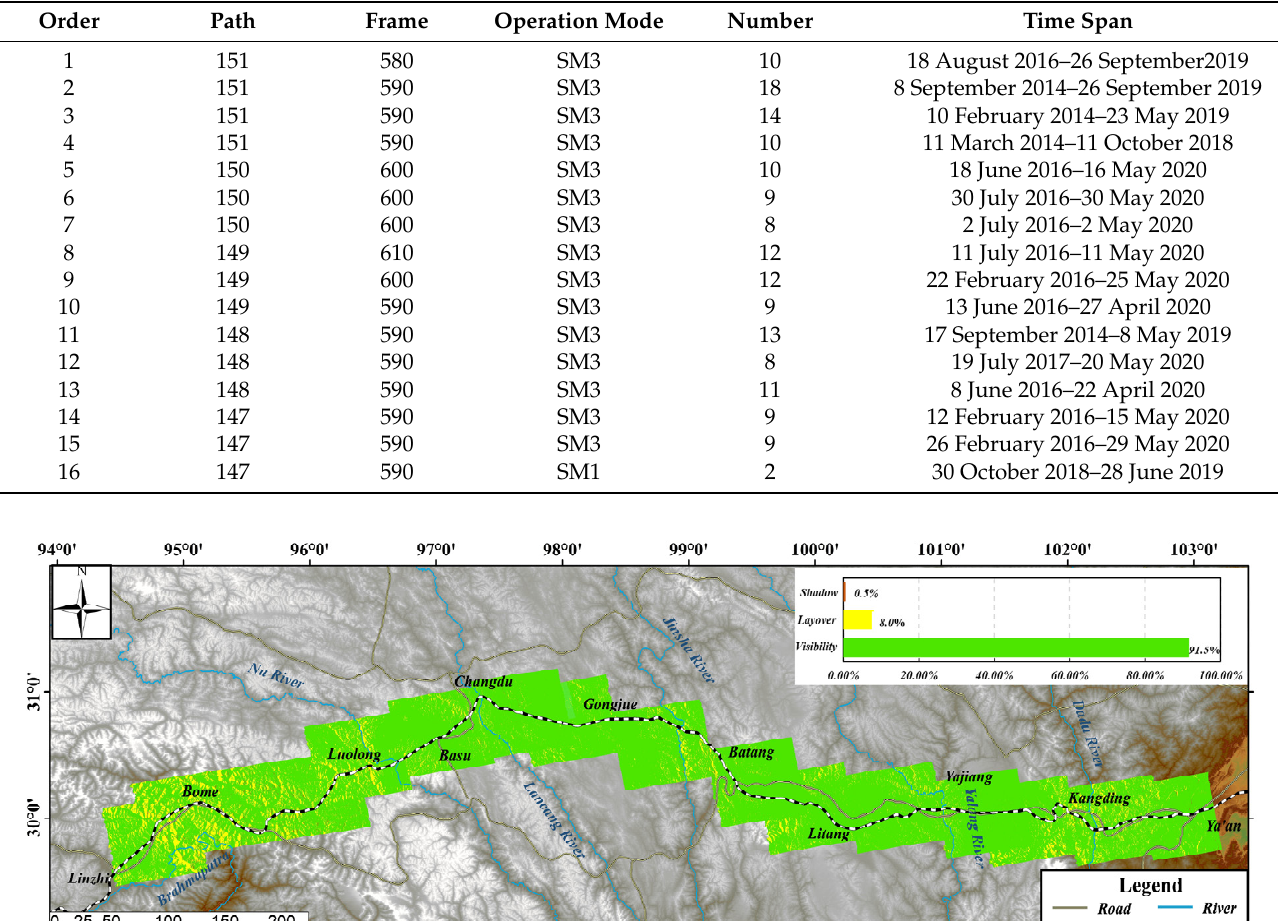
Table 1. Parameters of synthetic aperture radar (SAR) satellite images.